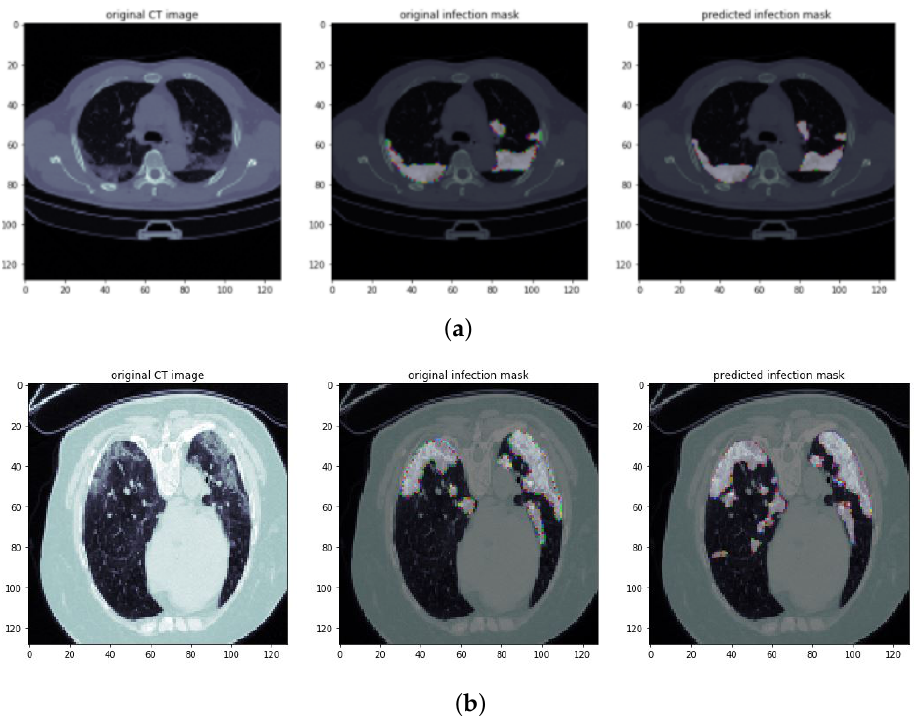
Figure 8. Infection segmentation results of CT scans: sample images ( a , b ) show the severe stage of viral infection. It can be seen that both lungs are affected by the COVID-19 infection badly. Columns 1–3 show an original CT scan image, an original infection mask, and a predicted infection mask,